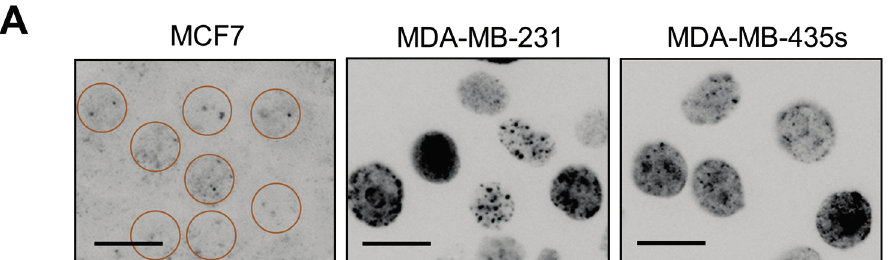
Figure 5. Serine 15-phosphorylated p53 protein levels in the indicated cancer cell lines. Scale bar, 20